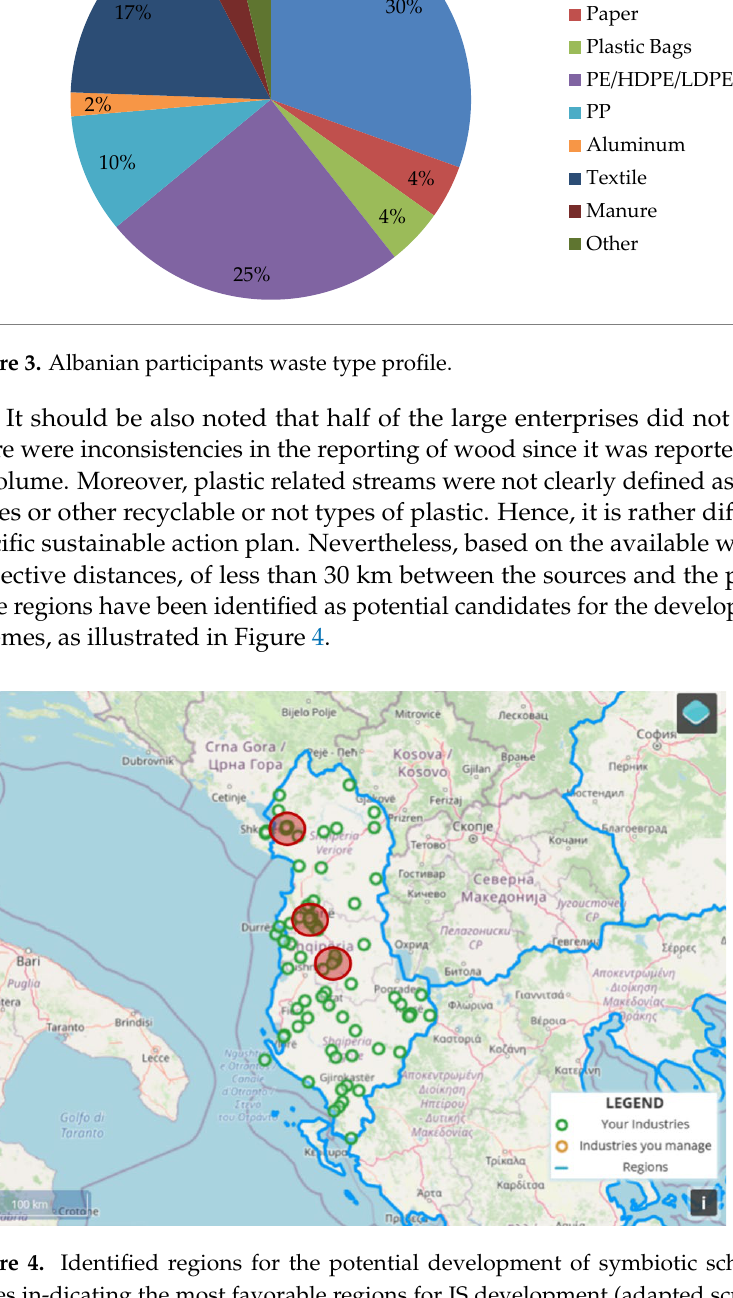
Figure 5. Map of Bulgarian participants (screenshot from www.swanplatform.eu, accessed on 13 May 2022). Regarding the answers of all the respondents to the four questions concerning their views on the key concepts, around 95% declared familiar with circular economy and a similar percentage interested to participate in symbiotic value chains. The reservations expressed for the high familiarization rates in the case of Albania apply in this case too.